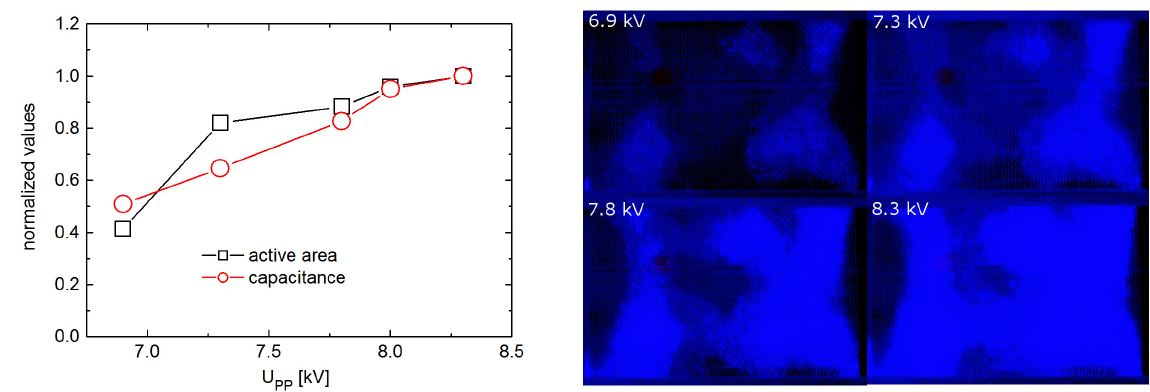
Figure 3: Left: Increase in active plasma area and increase in capacitance with respect to the operating voltage; Right: Photographs of the plasma operated at different